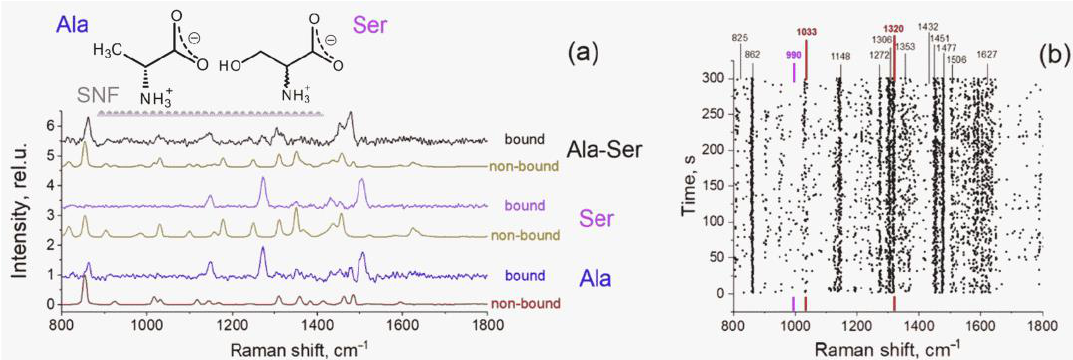
Figure 4. ( a ) Most significant spectral contributions (PC1 loadings) in the data matrices of Raman spectra of Ala, Ser, and 1:1 Ala-Ser mixture (theoretical sum) bound to SNF in PBS and in crystalline form (non-bound) Top: chemical structures of Ala and Ser in the vicinity of SNF (below the structures). ( b ) Raman peaks positions map for Ala-Ser mixture bound to SNF in PBS: black labels — Ala and Ser common peaks, magenta label — Ser only peak, red labels — Ala-Ser only peaks.